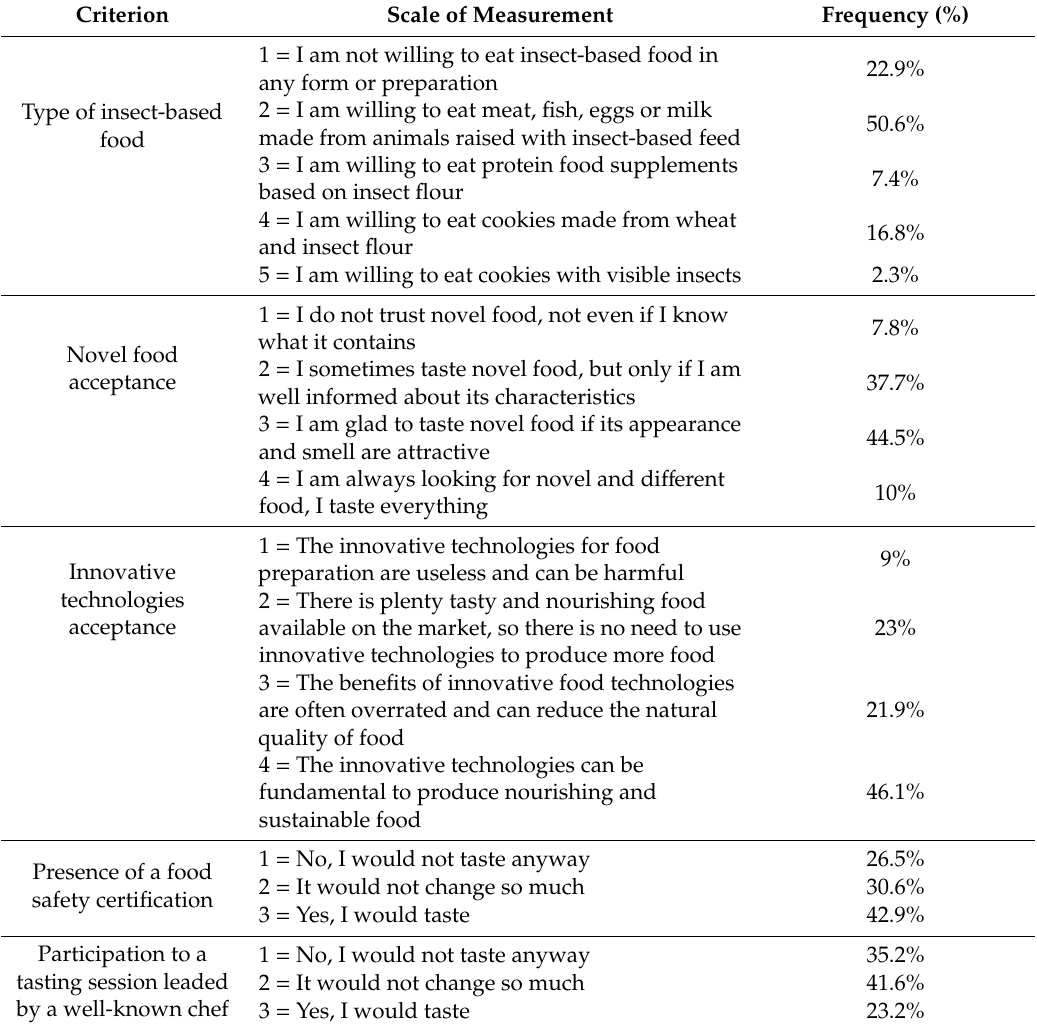
Table 3. Sample statistics on acceptance of novel food, innovative technologies for food preparation and other factors a ff ecting the willingness to taste insect-based